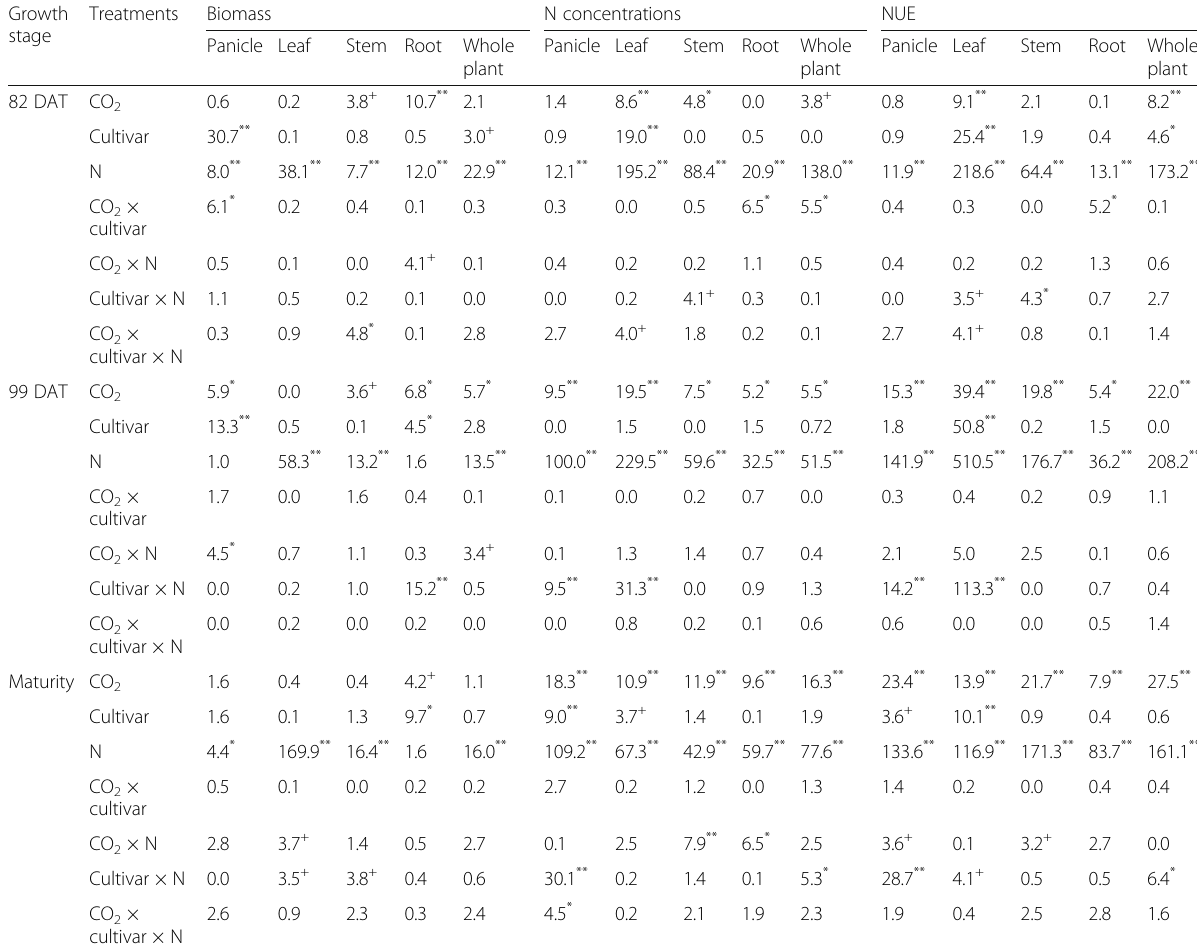
Table 2 F -value and the results of three-way ANOVA (type III) testing the elevated [CO 2 ], cultivar, N fertilizer, and their interactions on biomass, N concentration, and NUE of rice crops at three growth stages Growth Treatments Biomass N concentrations stage Panicle Leaf Stem Root Whole plant 82 DAT CO 2 Cultivar 30.7 **